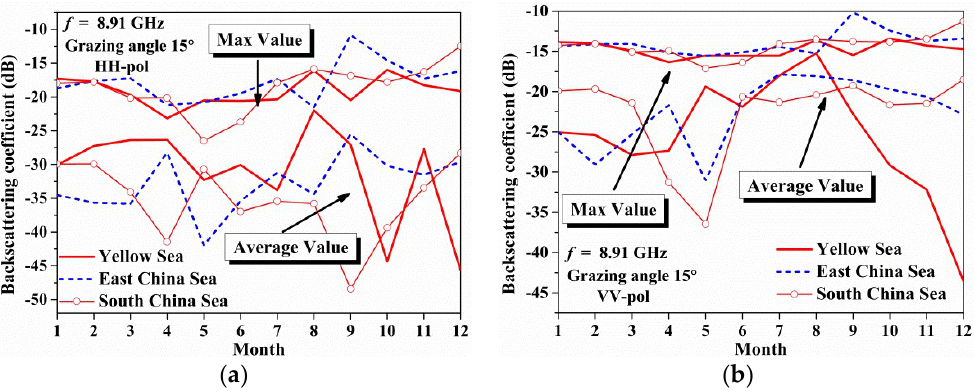
Figure 10. The figures show the monthly variation of the co-polarization backscattering coefficients in different seas, and both the averaged values and maximum values are plotted in the figures: ( a ) HH polarization; ( b ) VV polarization.